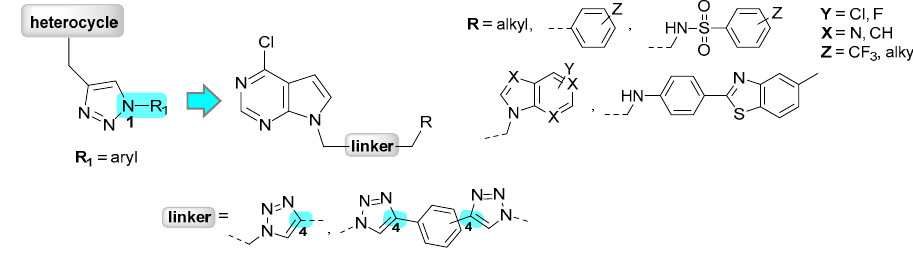
Figure 2. Design and synthesis of mono- and bis-pseudopurines with C-4 substituted 1,2,3-triazole scaffold.